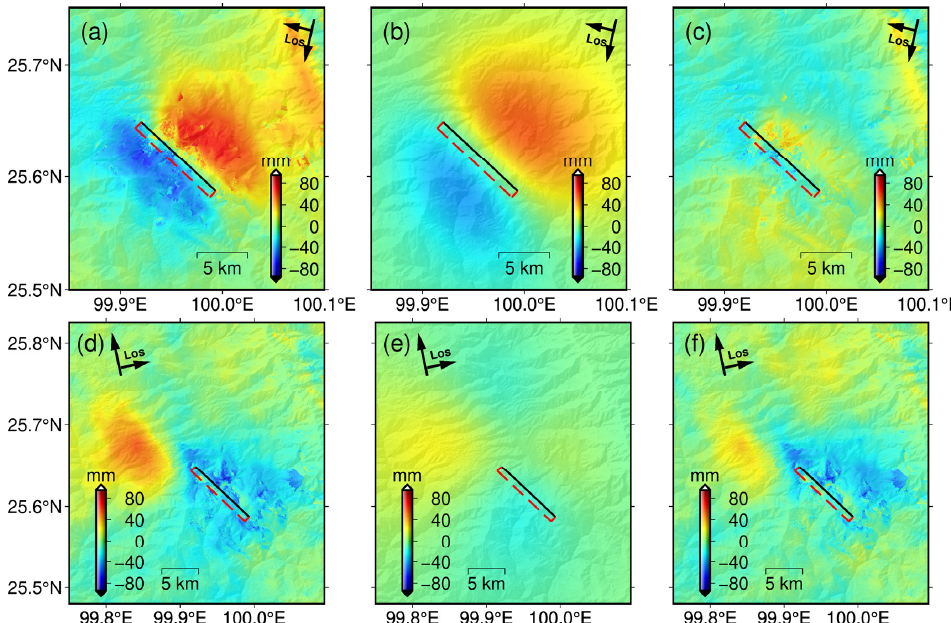
Figure 4. Inversion results of the uniform slip inversion model for the Yangbi earthquake; ( a ) and ( d ) are the observed coseismic interferograms of the descending and ascending tracks, respectively; ( b ) and ( e ) are corresponding modeled data; ( c ) and ( f ) are the residuals. In ( a )–( f ), thick black line depicts the fault surface trace of the uniform slip model while dashed red line shows the surface projection of the rupture fault plane.